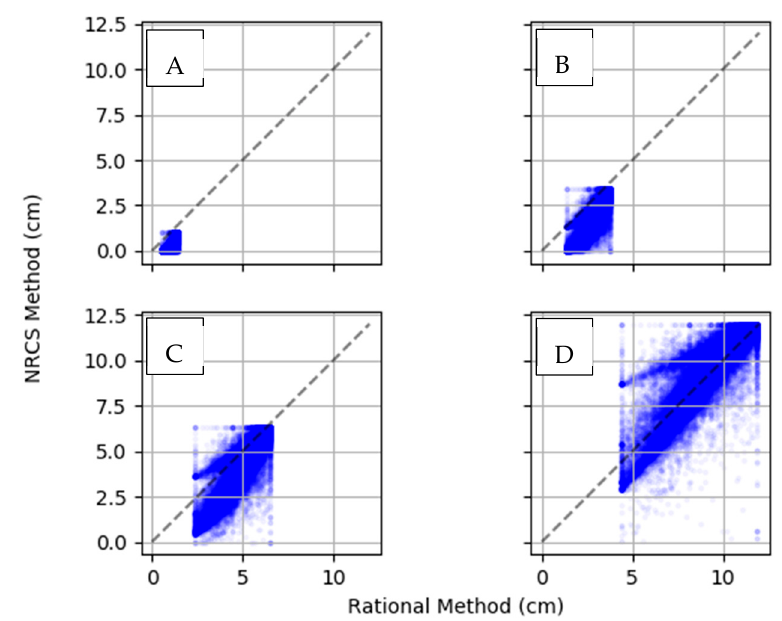
Figure 3. Change in runoff depth estimated by the modified rational and NRCS models for the 10-year design storm for the duration of ( A ) 5 min, ( B ) 30 min, ( C ) 3 h, and ( D ) 24-hour.